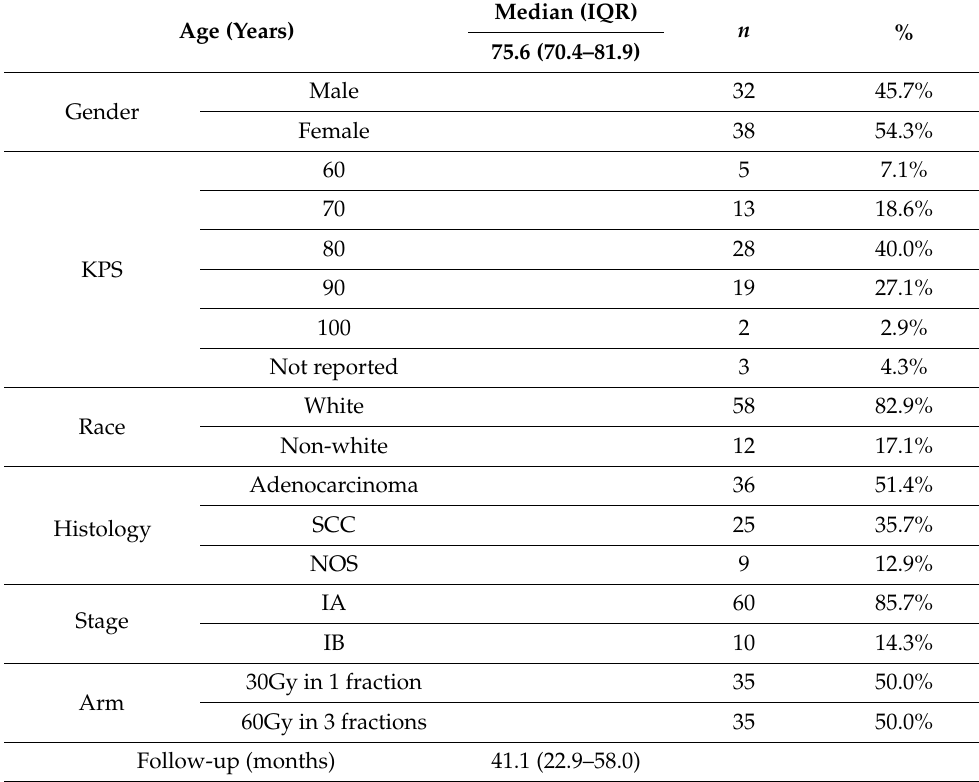
Table 1. Patient demographics.